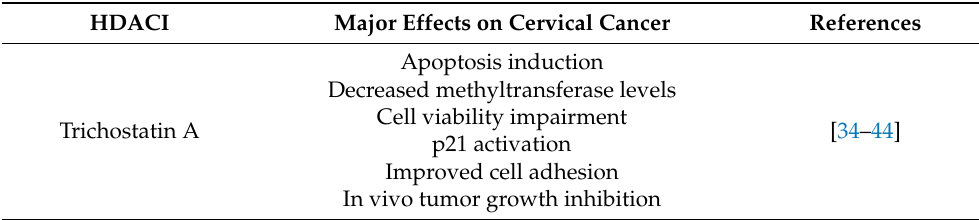
Table 2. Major effects of the most studied HDACIs as monotherapies on cervical cancer.